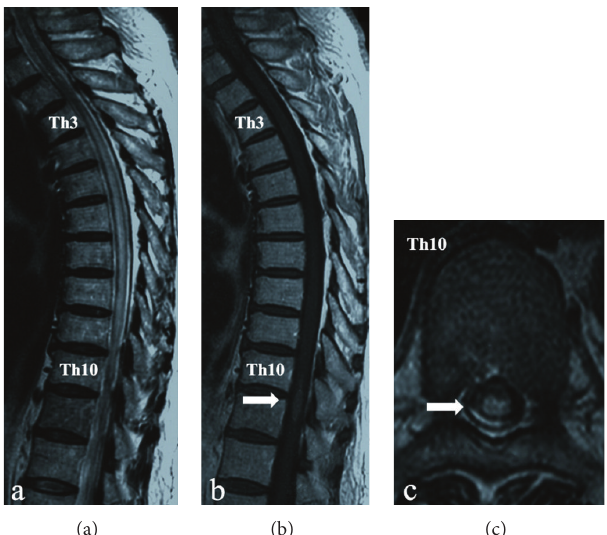
Figure 1: Thoracic magnetic resonance imaging reveals an intramedullary long spinal cord lesion from T3 to lower levels at 1 day after admission. (a) Sagittal T2-weighted image. (b) Gadolinium enhancement of the lesion at T10-T11. (c) Axial T2-weighted image at T10, revealing a high-intensity signal in the center of the spinal